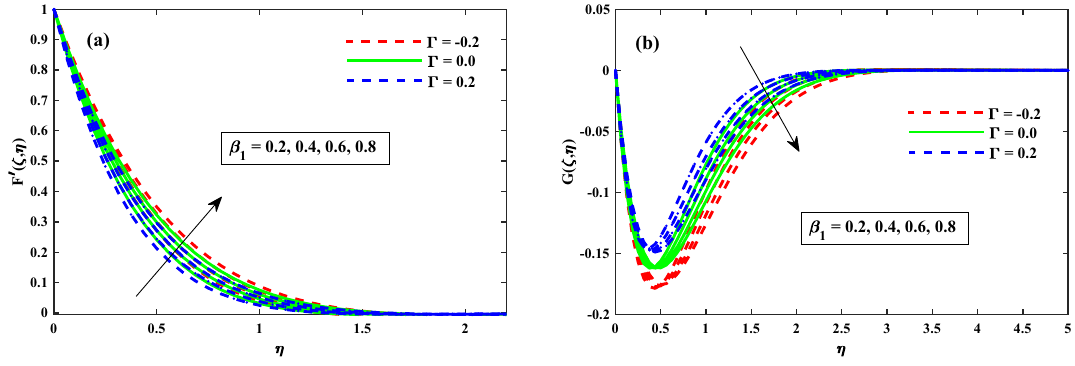
Figure 3. Impact of β 1 on F ′ (ζ , η) in x-direction, and G (ζ , η) in y-direction at ζ